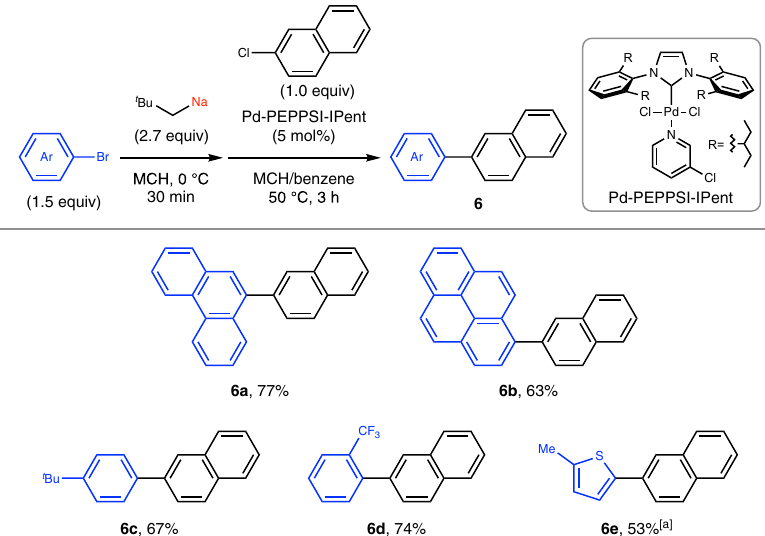
Fig. 7 Palladium-catalyzed direct cross-coupling reactions using arylsodiums. Conditions: step 1, neopentyl chloride (270 mol%) and SD (570 mol%) in methylcyclohexane (MCH, 2.0 mL) at 0 °C for 20 min; step 2, ArBr (1.5 equiv) was added at 0 °C, 30 min; step 3, Pd-PEPPSI-IPent (5 mol%), 2- chloronaphthalene (0.30 mmol, 1.0 equiv), and benzene (1.0 mL) were added and the cross-coupling reaction was performed at 50 °C for 3 h. Yields determined by isolation are shown. a Coupling reaction for 1 h. SD sodium dispersion, Ar aryl, t Bu tert -butyl, Me